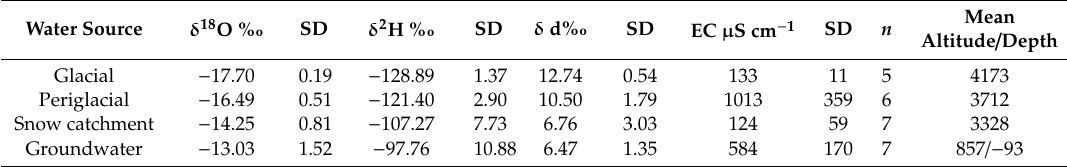
Note: For glacial environment were considered as representative the samples obtained in summer. For periglacial water sources were considered the samples obtained in summer and autumn. Snow catchment samples